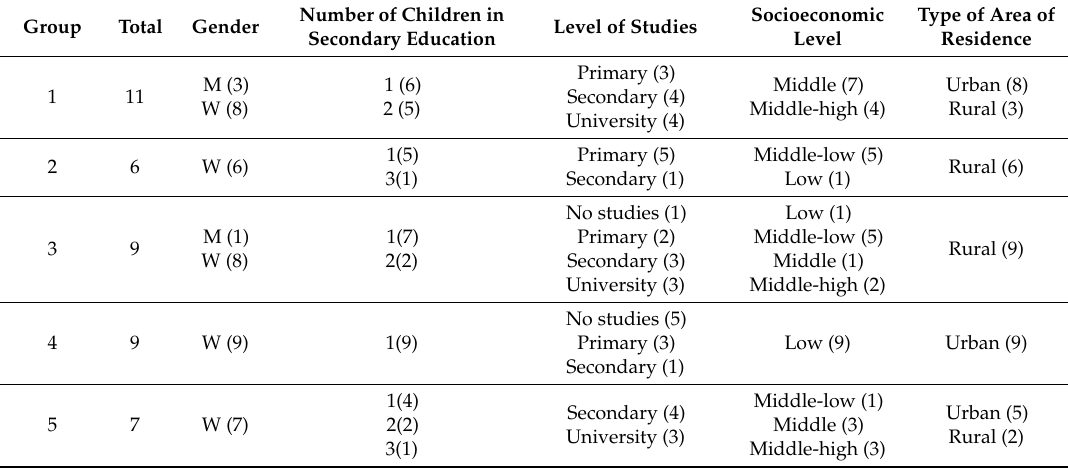
Table 1. Structure and Profile of the focal groups’